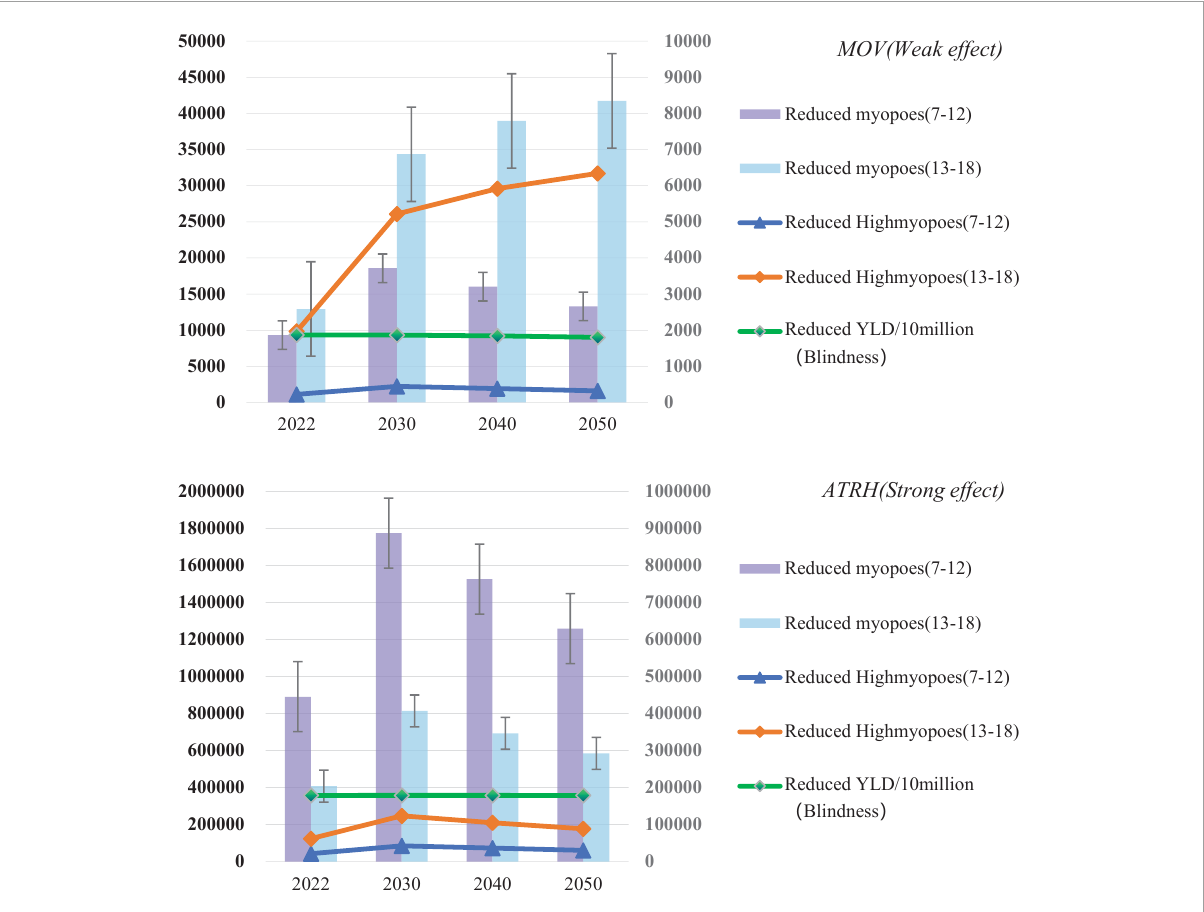
FIGURE4 Estimates for 2022–2050 after MOV (weak effect) and ATRH (strong effect) are 100% covered: the number of myopia reductions, the number of high myopia reductions, and the rate of Years Lived with Disability (YLD) (blindness)